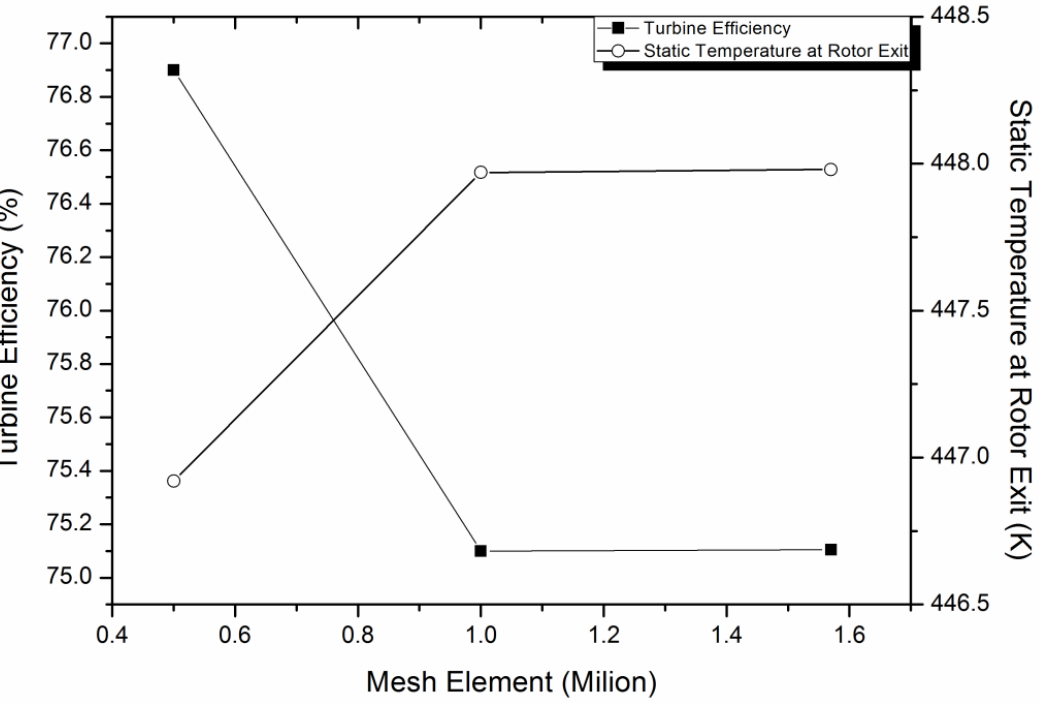
Figure 13. Mesh independence study using ANSYS TurboGrid.